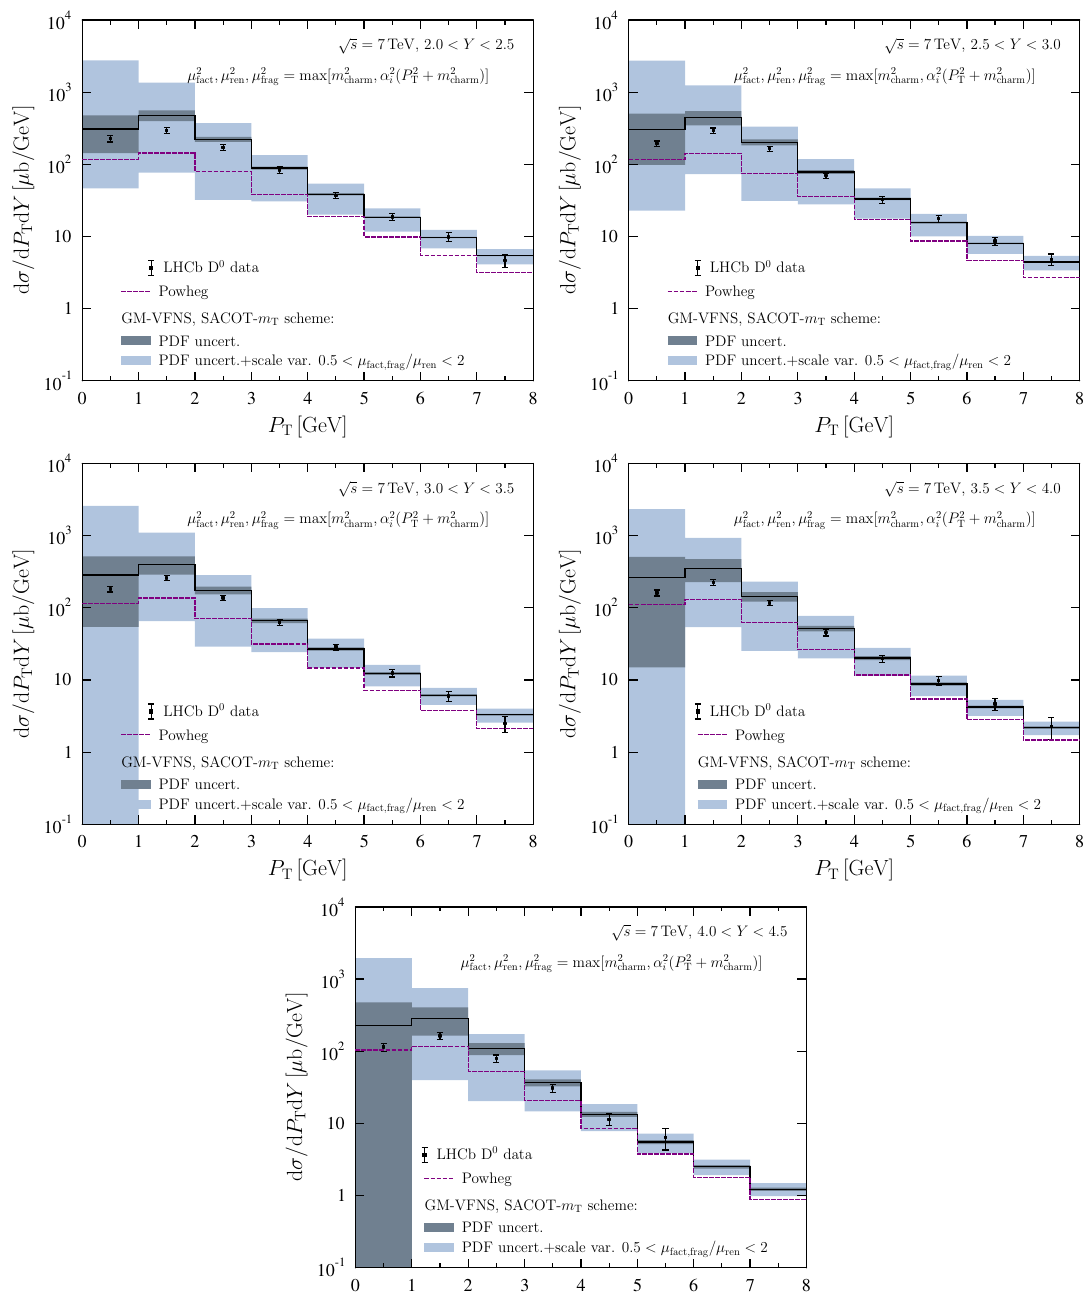
p Figure 8 . A comparison of the LHCb s = 7 TeV D 0 + D 0 data [1] with the GM-VFNS and Powheg calculations. The black lines indicate the central GM-VFNS results, the PDF uncertainty is shown as darker band, and the light-blue band is the PDF uncertainty and scale variation added in quadrature. The purple dashed line is the central result from Powheg